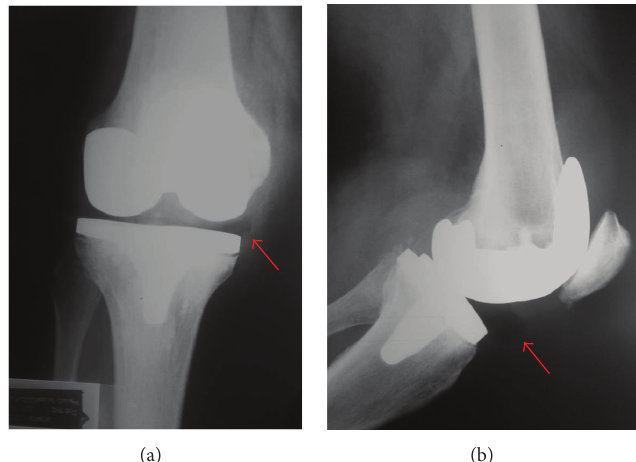
Figure 1: Anteroposterior (a) and lateral (b) radiographs of the right knee demonstrating a sign of anterior tibial insert dislocation.